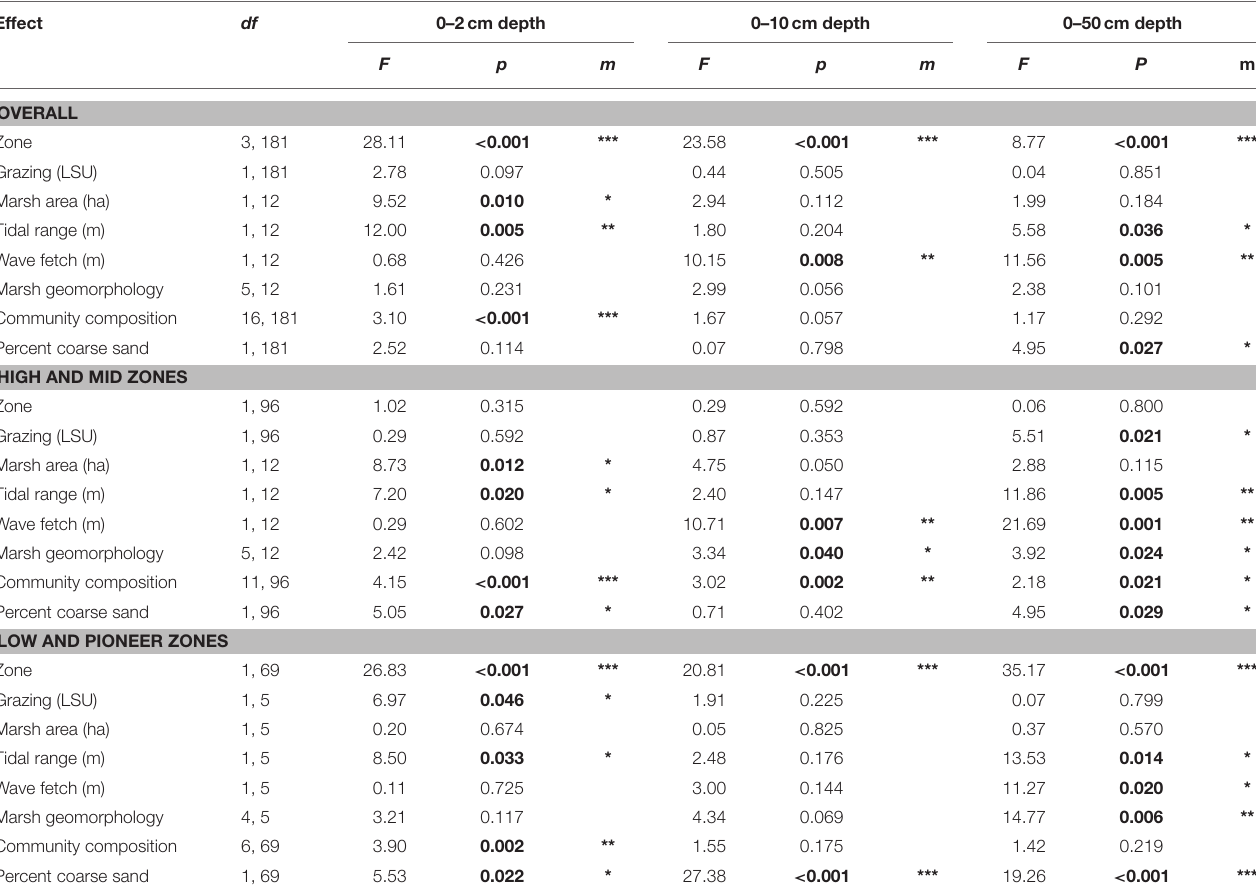
TABLE 2 | ANOVA output from mixed effects model.